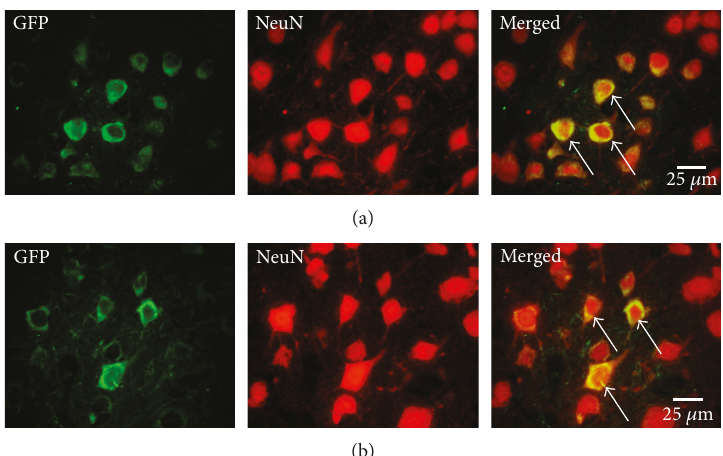
Figure 6: Immunohistochemistry for GFP and NeuN. Panels (a) and (b) show fl uorescent photomicrographs adjacent to the cerebral infarct 5 weeks posttransplantation in the BMSC/direct injection (a) and BMSC/sca ff old (b) groups. Green: GFP; red: NeuN. Arrows indicate coexpressing cells. Scale bars: 25 μ m.